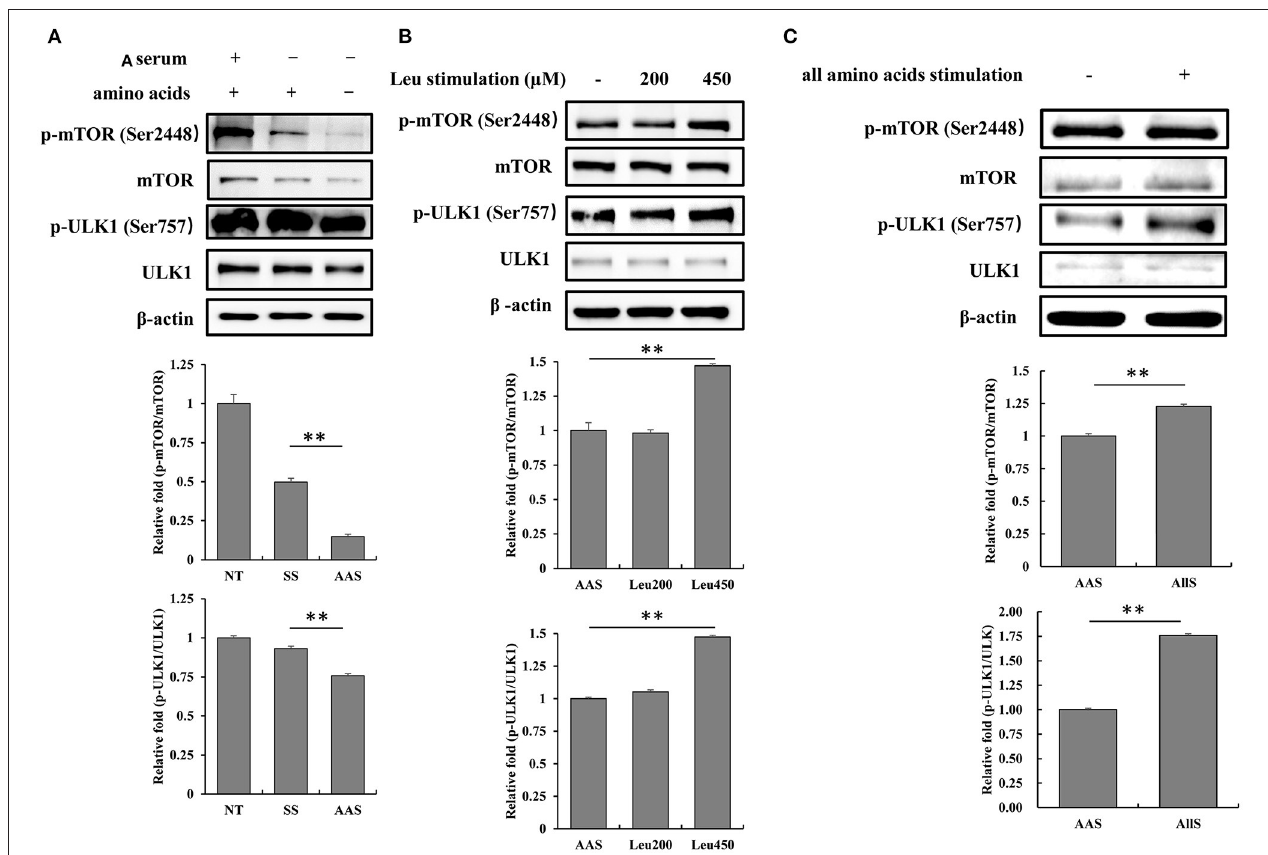
FIGURE 2 | Amino acid starvation and restimulation with amino acids influenced mTORC1 activity in goat fetal fibroblasts. (A) The proteins were extracted from cells in non-treated condition (NT group), serum starvation medium for 16h (SS group), and amino acid starvation medium for 1h after serum starvation (AAS group). Then, the expression and phosphorylation levels of mTOR and ULK1 proteins were analyzed by immunoblotting. mTORC1/ULK1 signaling was attenuated by amino acid starvation. (B) GFb cells were subjected to amino acid starvation for 1h, after serum starvation for 16h, and then restimulated with leucine at concentrations of 200 and 450 µ M. The cells were lysed, and the expression and phosphorylation levels of mTOR and ULK1 proteins were analyzed by immunoblotting. The restimulation with leucine improved mTORC1/ULK1 signaling. (C) GFb cells were subjected to amino acid starvation for 1h, after serum starvation for 16h, and then restimulation with all amino acids. The cells were lysed, and the expression and phosphorylation levels of mTOR and ULK1 proteins were analyzed by immunoblotting. The restimulation with all amino acids enhanced mTORC1/ULK1 signaling. All bands were quantified using Gel-Pro Analyzer 4.0 (* p < 0.05, ** p < 0.01, n = 3